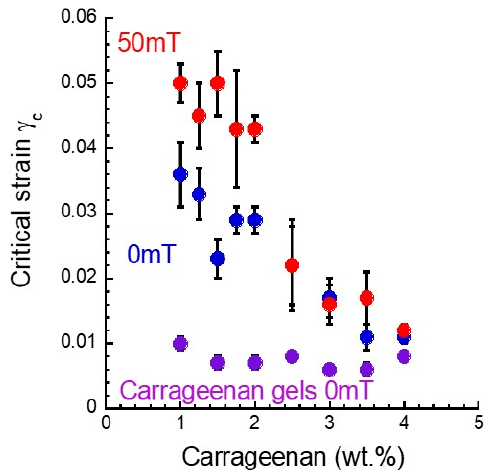
Figure 4. The relationship between the critical strain and carrageenan concentration for magnetic gels with a concentration of 50 wt.% and carrageenan gels without magnetic particles.